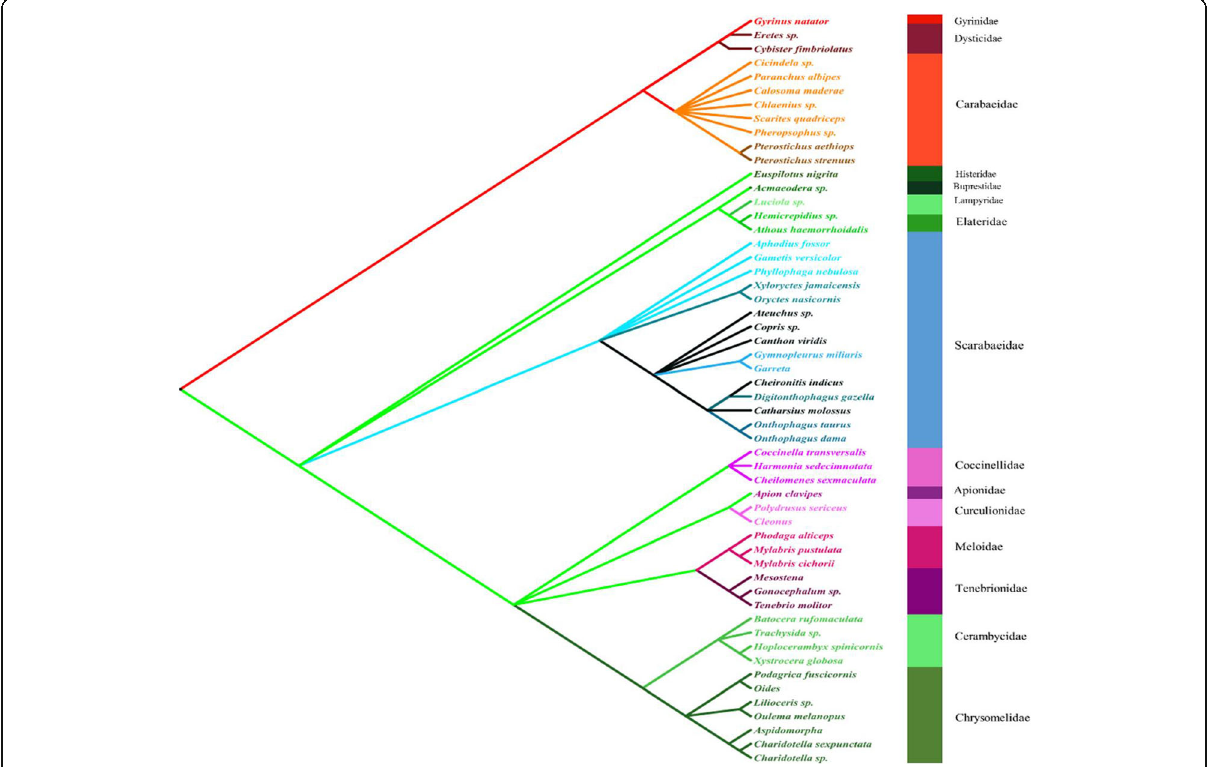
Fig. 7 Diagram of the phylogenetic tree obtained from 54 species of Coleoptera. The families ’ clades are represented at right side of species belonging to it respectively. Some of the species, not having any sequencing record in NCBI, are not included. Color coding was emphasized so as to highlight different taxonomic levels in Polyphaga (12 families) and Adephaga (3 families)